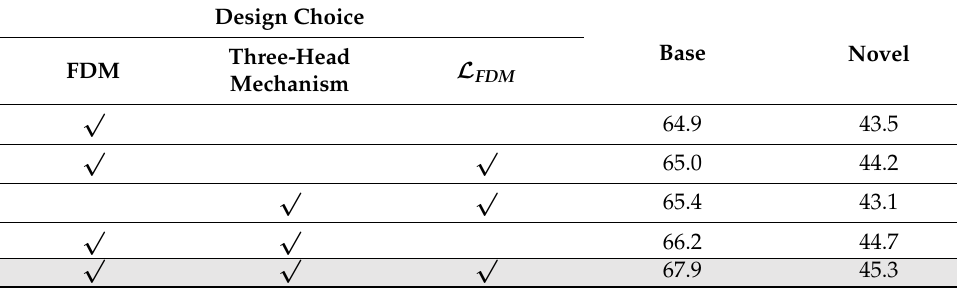
Table 5. Ablation studies of several design